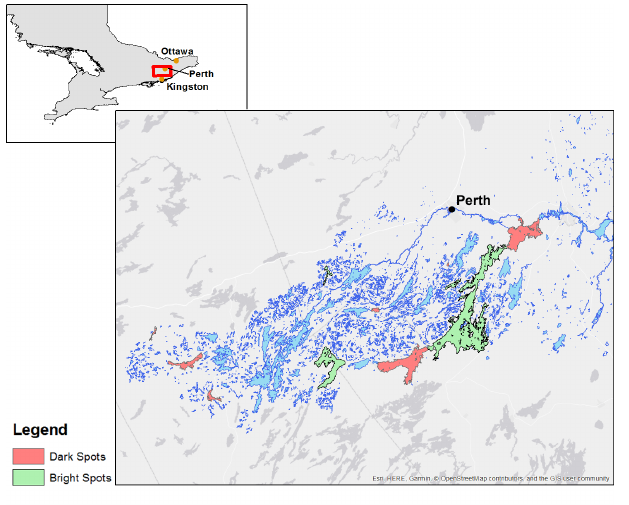
Fig. 5 . Lakes with identified bright and dark spot sites in the study area, with the regional center of Perth, Ontario.